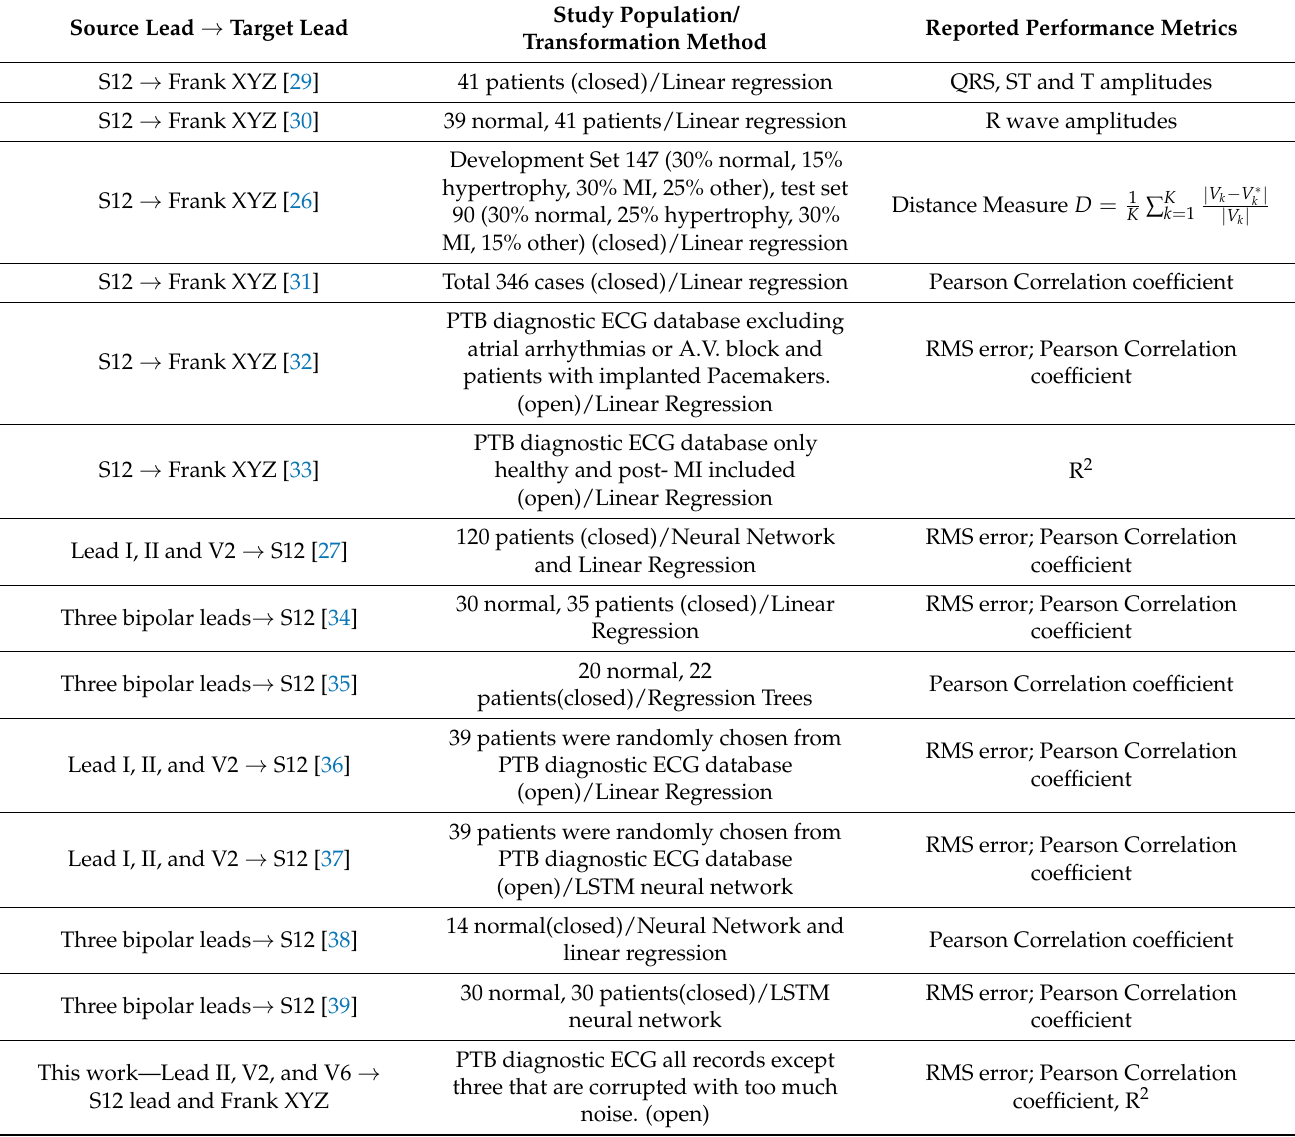
Table 1. Related work in the literature that proposes lead